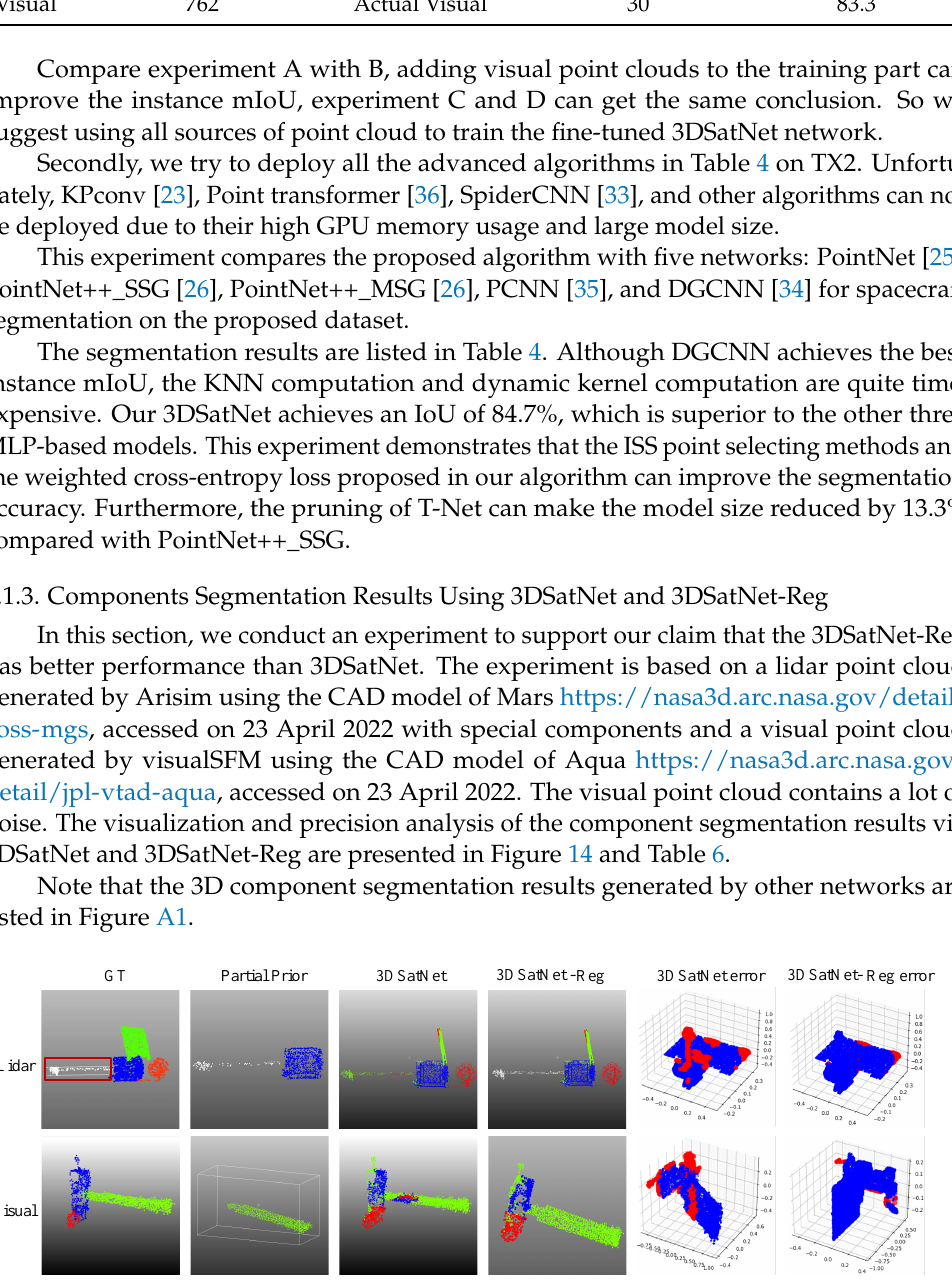
Figure 14. Visualization of the component segmentation results via different networks. (Blue: panel, Green: body, Red: Antenna, Grey: special components. In 3DSatNet error and 3DSatNet error Figures: red points represent wrong segmented points, blue points represent points that are segmented